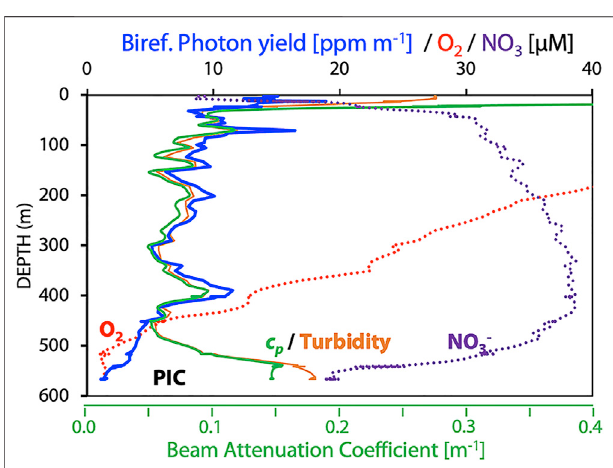
FIGURE 15 | Comparisons of pro fi les of birefringent photon yield, turbidity, beam attenuation coef fi cient, oxygen, and nitrate at cast 2 in the Santa Barbara Basin. The data from the PIC sensor decreased strongly in the suboxic and nitrate-de fi cient layer below 500 m in contrast with both beam attenuation coef fi cient and turbidity which indicated higher particle concentrationsinthenepheloidlayerasthebottomwasapproached.Theloss of PIC in strongly oxygen-de fi cient near bottom waters is consistent with behavior observed at 11 ° N during the GEOTRACES expedition.